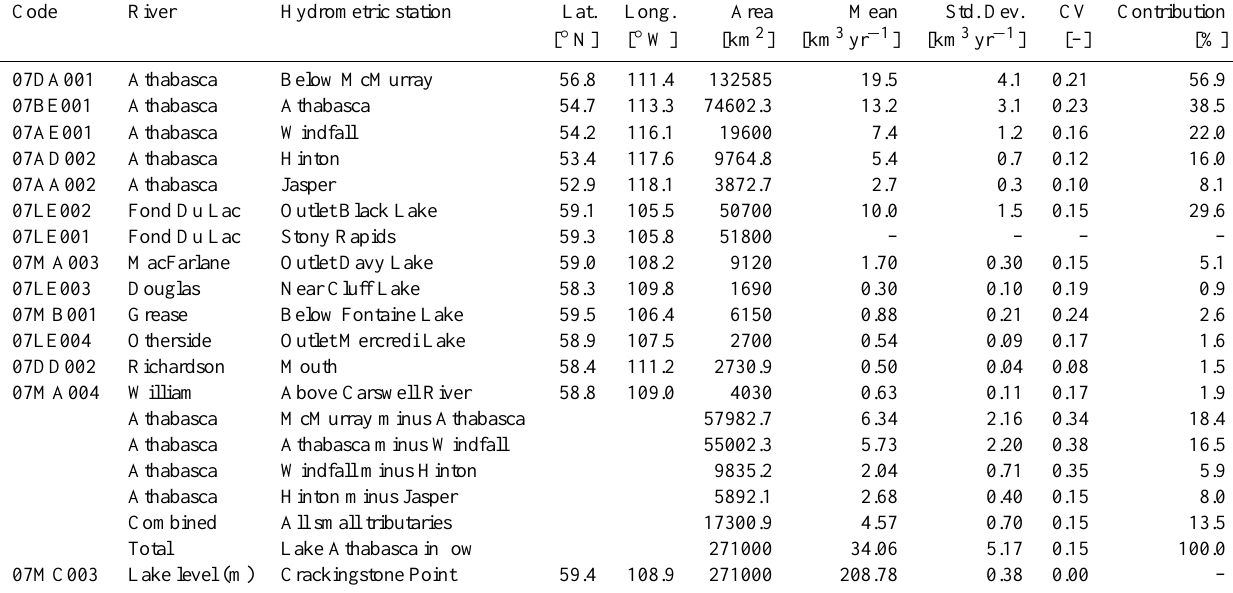
Table 1. List of hydrometric gauges in the study area and corresponding discharge statistics. Discharge difference between two immediate gauges on the Athabasca River, combined gauge area for small rivers, and total lake inflow information over 1960–2010 are also provided.